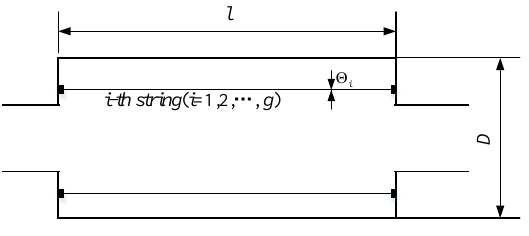
Figure 6. Schematic diagram of the single-chamber RSHPA.